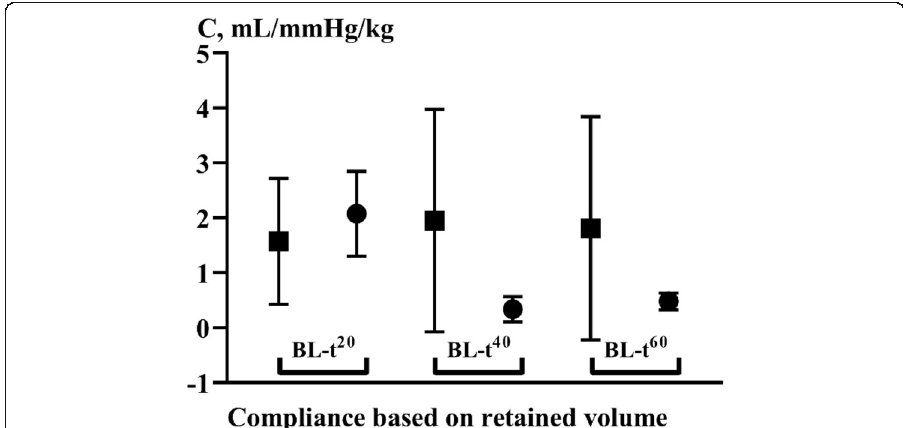
Fig. 7 The compliances calculated from change in P msa from baseline to t 20 , t 40 and t 60 , and volume infused differed significantly between crystalloid and colloid ( p =<0.0001, 0.0013 and 0.0034) at identical time points. Crystalloid, full square; colloid, full